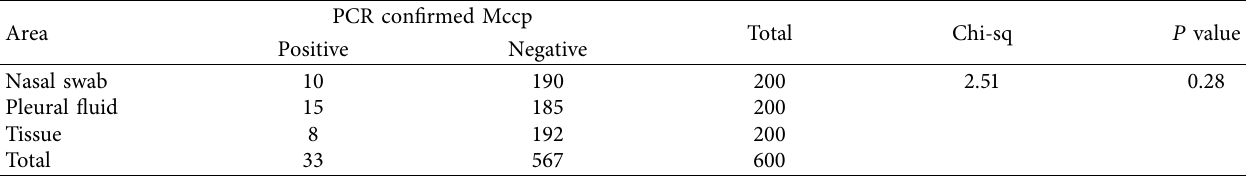
Table 4: Statistical analysis of molecular identification of Mycoplasma capricolum subsp. capripneumoniae by PCR from the different clinical samples of goats in southern areas of Khyber Pakhtunkhwa, Pakistan.